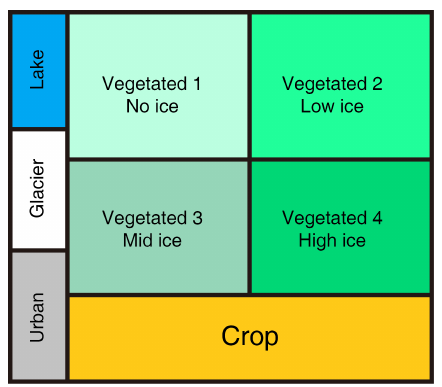
Figure 1. Modification of the CLM5 tiling hierarchy on the land unit level containing four natural vegetated land units for different excess-ice